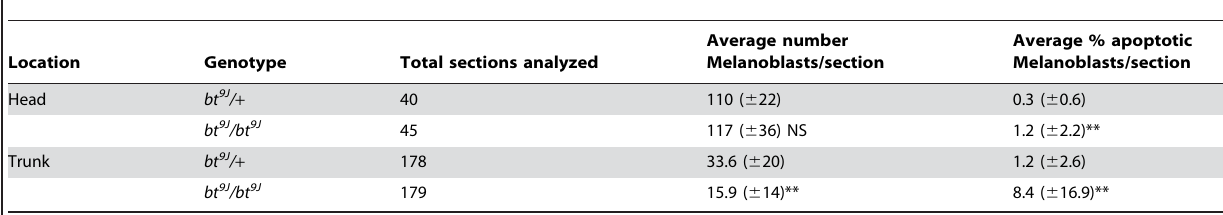
Table 2. Quantitation of Melanoblasts in sections through the head and trunk at E13.5.